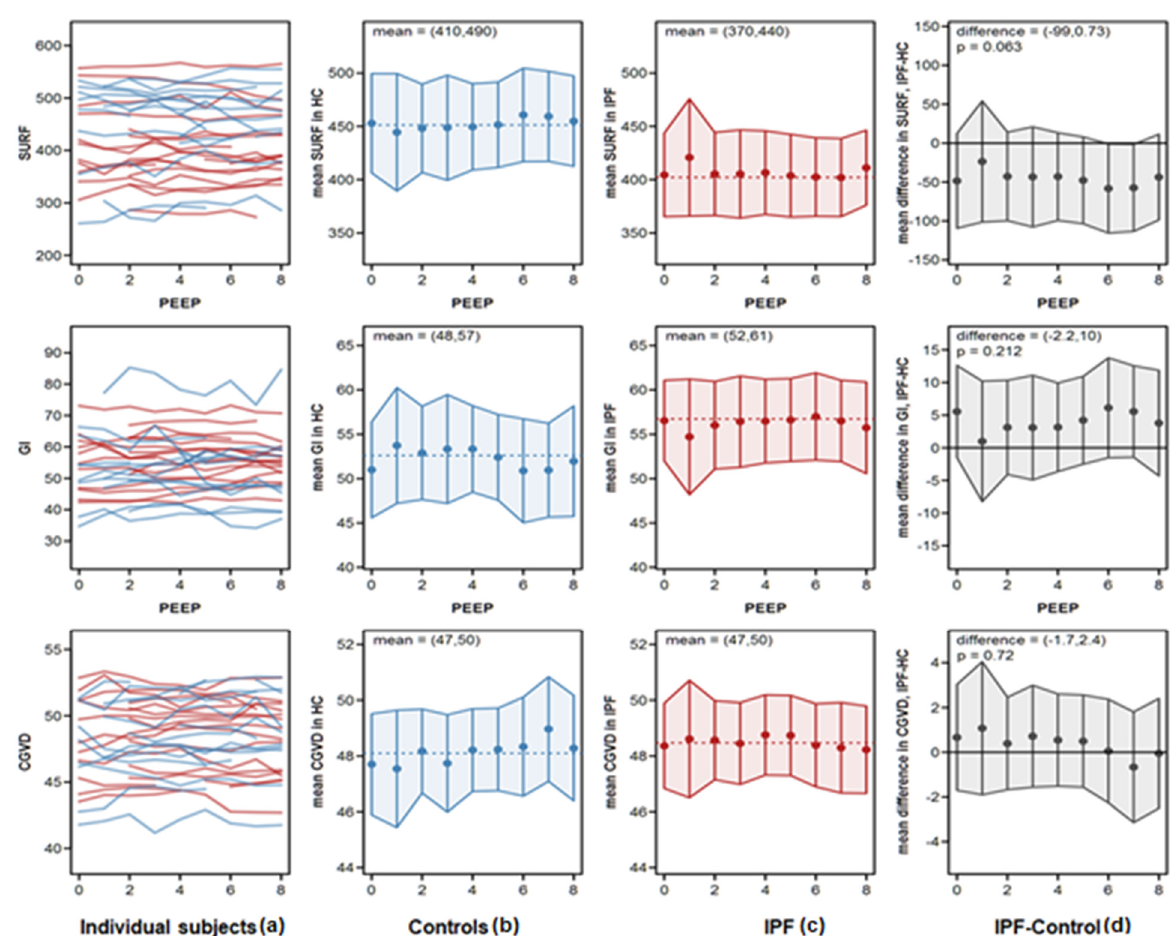
Figure 2. Global change in surface of ventilated areas (SURF), global inhomogeneity index (GI) and center of ventilation (CGVD) during PEEP titration. Panels show, from left to right: ( a ) patient’s individual trajectories, ( b ) mean values by PEEP in controls, ( c ) mean values by PEEP in IPF patients, and ( d ) mean differences between IPF patients and controls. Blue lines indicate data from controls; red lines indicate data from IPF patients. Points are mean values; error bars are point-wise 95% confidence intervals. The dotted lines are the model fits for the change over PEEP. The 95% confidence intervals of the slopes of these lines are indicated in the panels. The difference in the right panels is the 95% confidence interval of the difference between the slopes for IPF patients and controls.